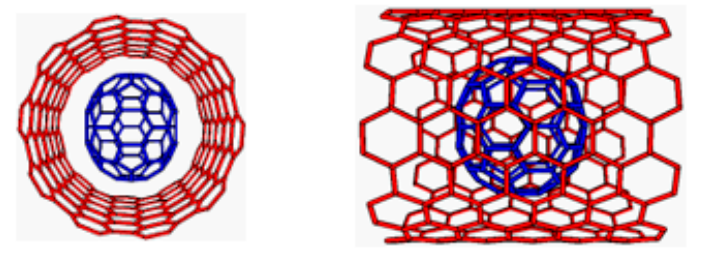
Figure 2. Model of a carbon nano-peapod with C 70 fullerene encapsulated within a single-walled (10, 10) carbon nanotube.